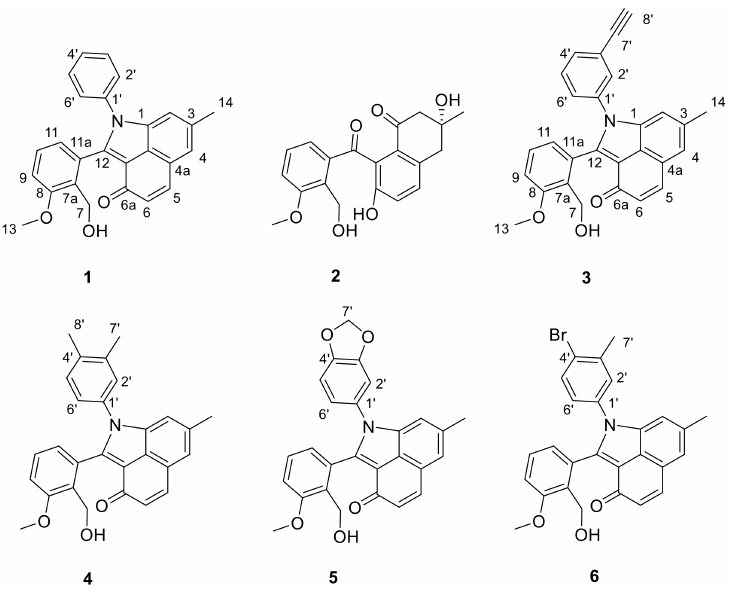
Figure 1. The structure of compounds 1 – 6